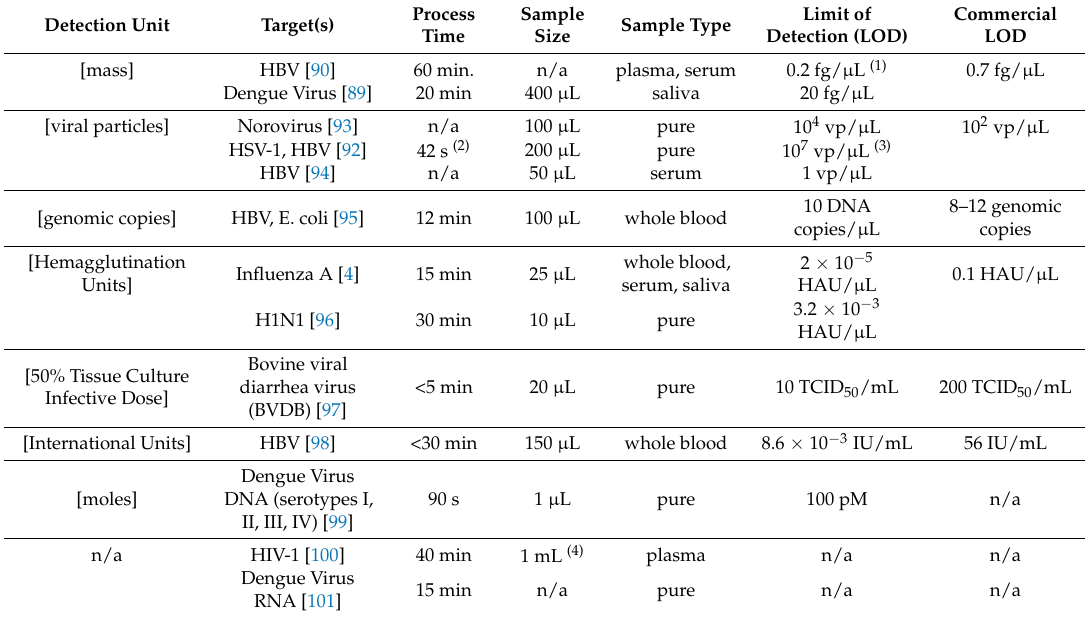
Table 4. Viral detection methods via nano-microfluidics, grouped by detection